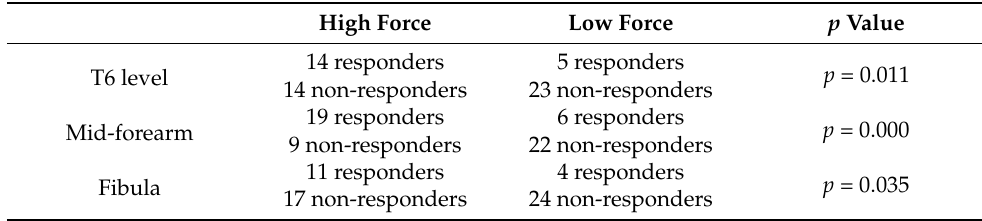
Table 1. X 2 = Chi-square analysis based on standard error of measurement (SEM). Number of responders ( n = 28).